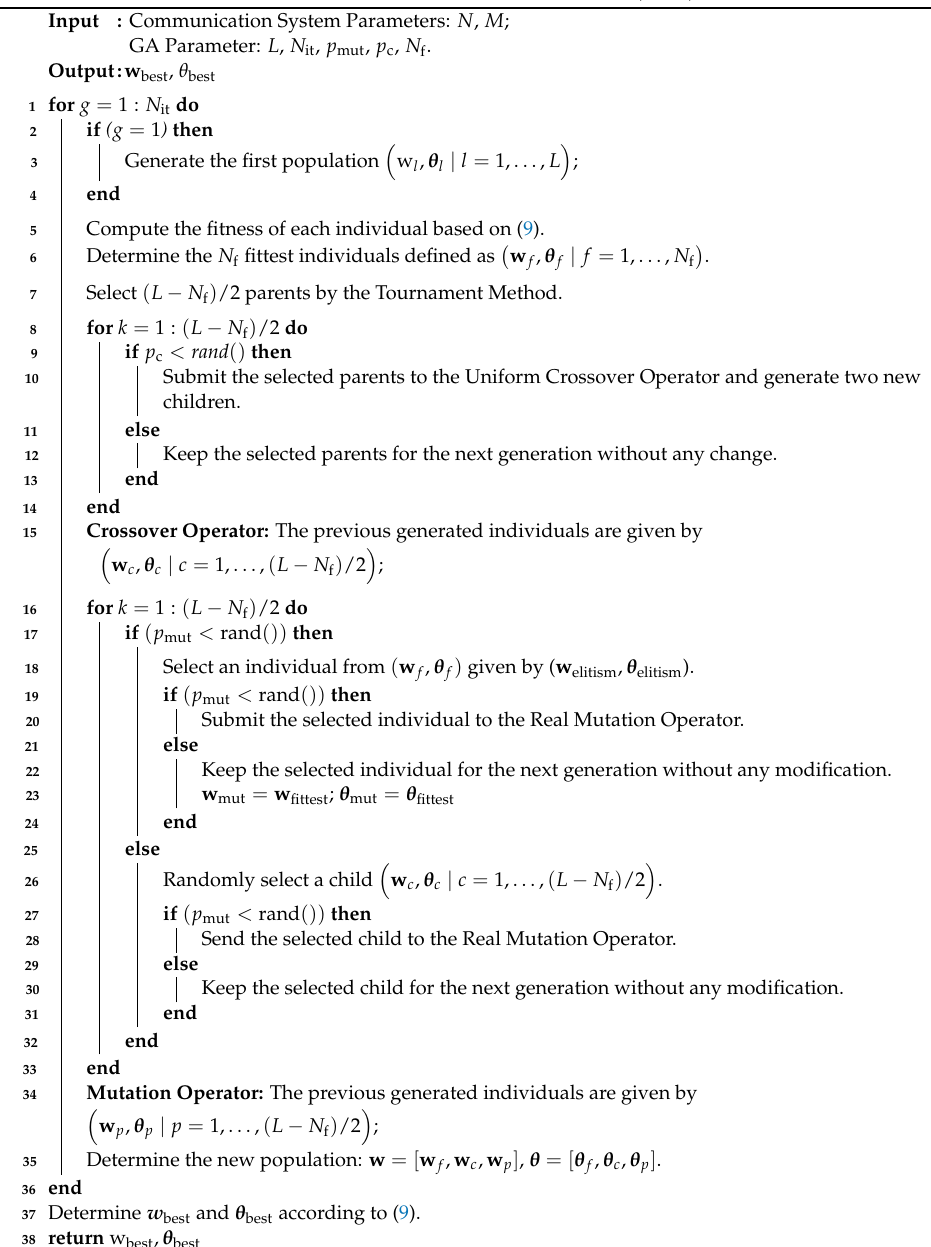
Algorithm 2: Algorithm applied in Phase 3 to compute